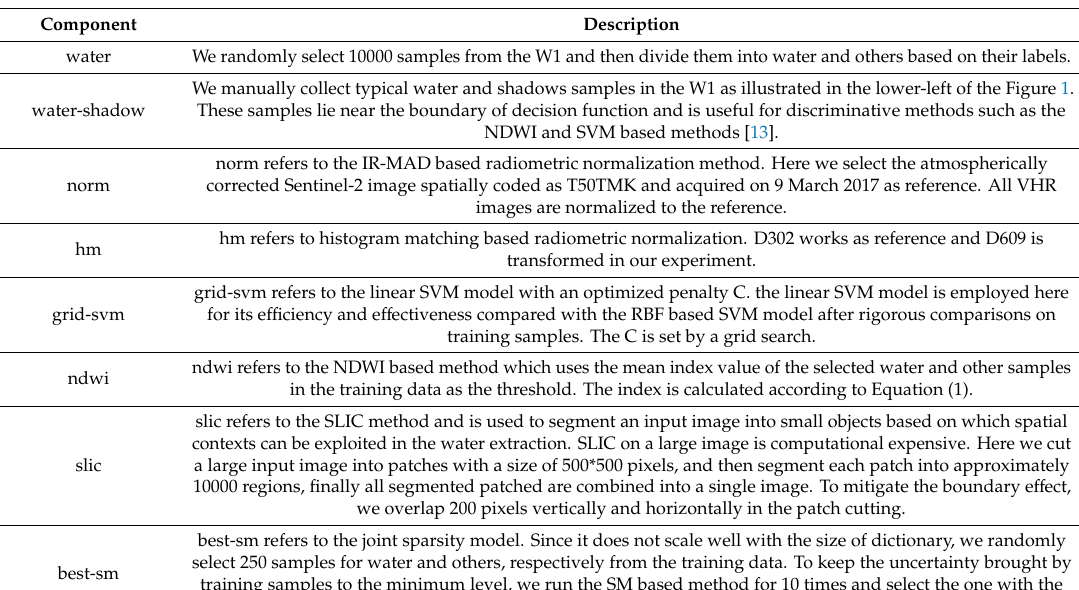
Table 3. List of components of the methods in the comparison.